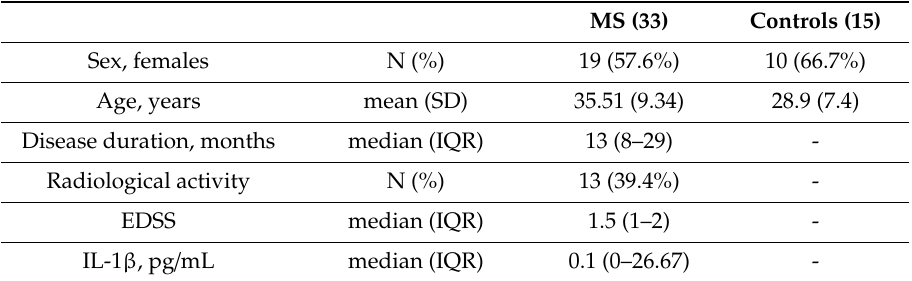
Table 1. Clinical Characteristics of MS Patients and